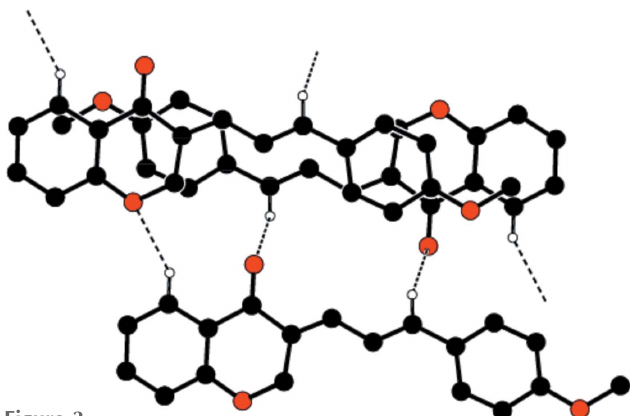
Figure 3 A partial view of the packing of the title compound showing the hydrogen bonds as dashed lines.